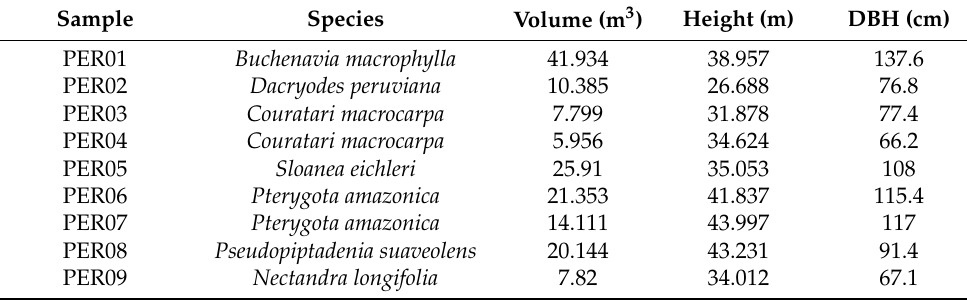
Table 2. Experimental results of the proposed method for 29